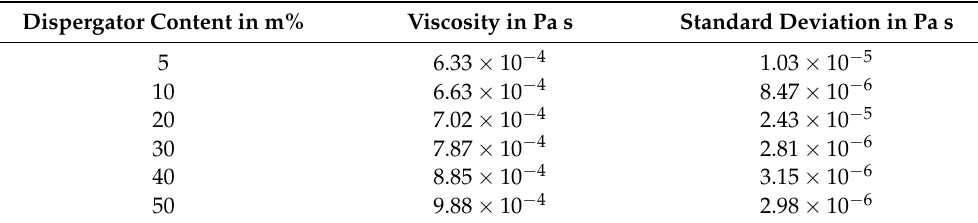
Table A4. Viscosity values as a function of TX-100 content for a TX-100 solution without nanoparticles. Dispergator Content in m%